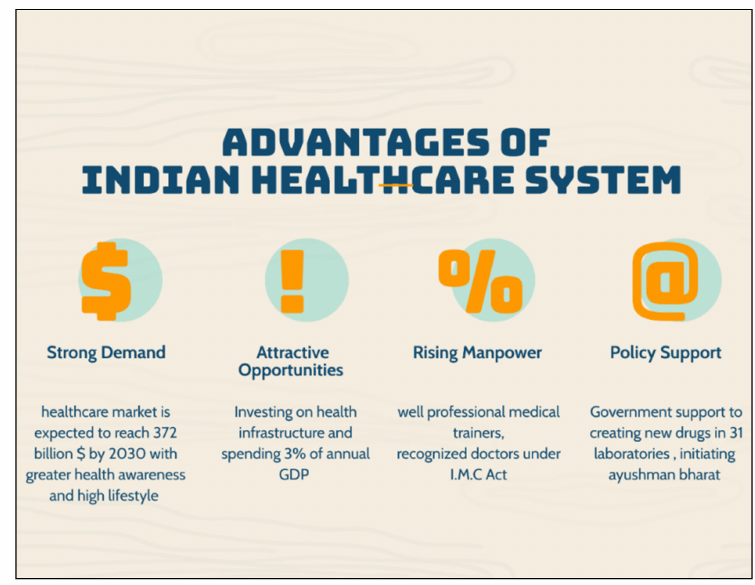
Figure 6. Advantages of the Indian healthcare industry